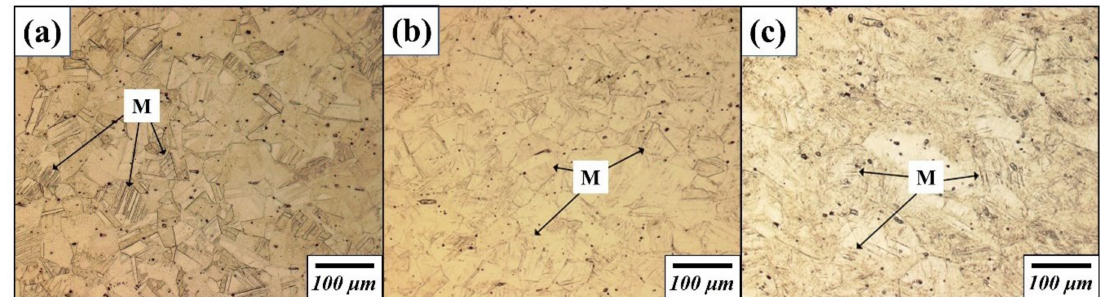
Figure 1. Optical microstructure of damaged Fe-22%Mn-12%Cr-4%Co-3%Ni-2%Si damping alloy under ( a ) 0, ( b ) 105, and ( c ) 245 MPa fatigue stress.